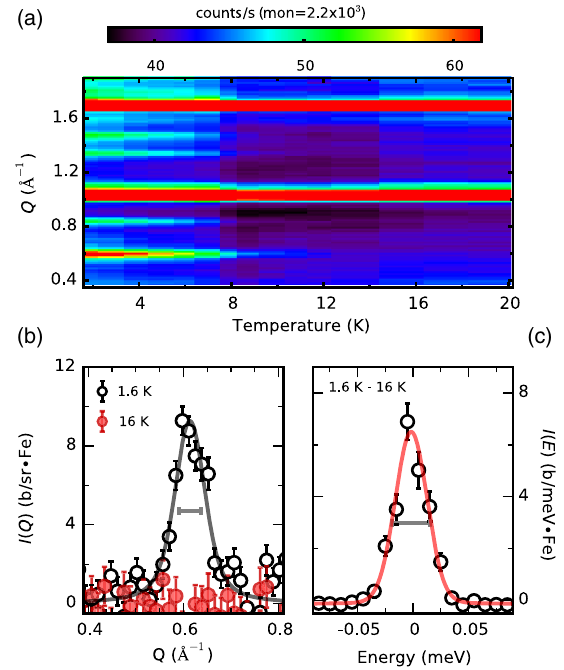
FIG. 1. (a) Overview of the temperature-dependent neutron diffraction intensity in FeSc 2 S 4 as measured on MACS. Data were acquired for a fixed monitor count (mon). (b) Magnetic Bragg reflection measured on CNCS integrated between − 0 . 018 < E < 0 . 018 meV. An identical constant background has been subtracted from low- and high-temperature data sets. (c) Energy dependence of magnetic Bragg reflection integrated over 0 . 52 < Q < 0 . 72 Å − 1 . Horizontal bars in (b) and (c) indicate the instrumental resolution as determined from corresponding cuts through the nuclear (111) Bragg peak at 1 . 04 Å − 1 . Error bars represent 1 standard